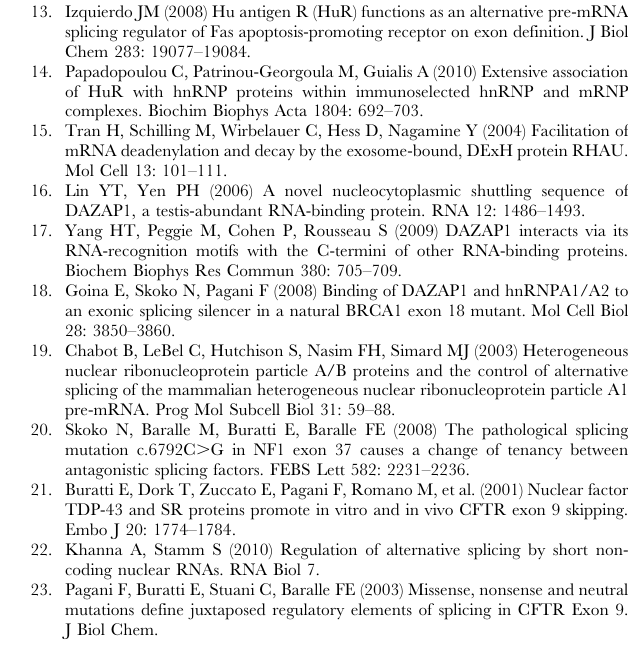
Figure S1 Over-expression of HuR, DAZAP1, hnRNPA1 and RNA helicase DHX36 proteins in HeLa cells. Western blot analysis on HeLa cells non-transfected ( 2 ) and transfected ( + ) with expression vectors for HuR, DAZAP1, hnRNPA1 and RNA helicase DHX36. The proteins were tagged with flag and their expression was detected using corresponding antibody. Table S1 Oligonucleotide sequence for mutagenesis experi- ments. Table S2 Sequence of RNAi